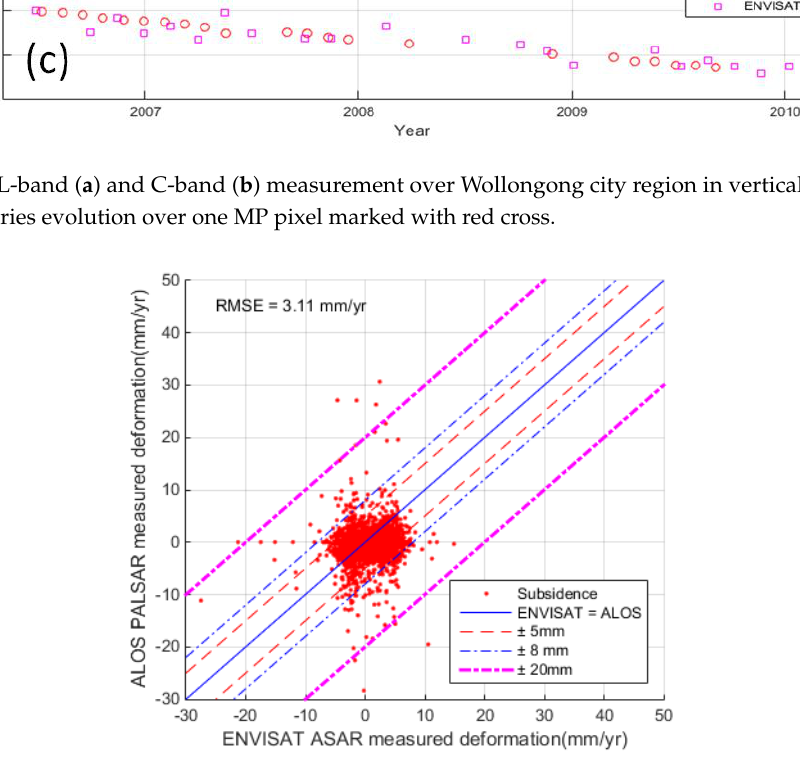
Figure 4. Comparison over Wollongong between L-band and C-band TS-InSAR results.